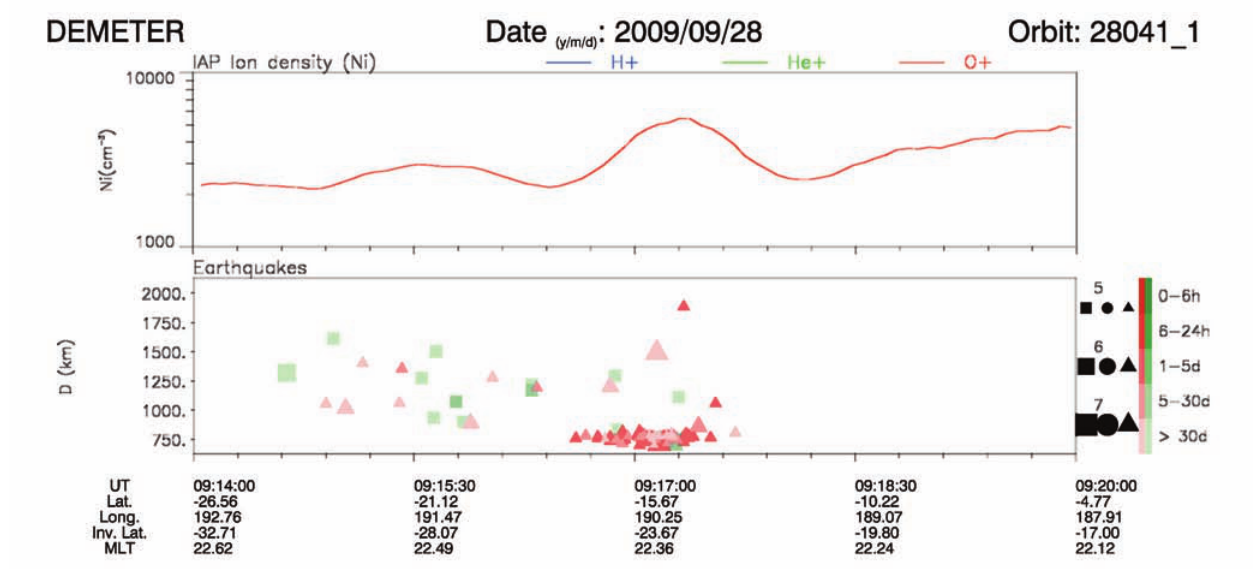
Figure 2. Data recorded on September 28, 2010, between 09.14.00 UT and 09.20.00 UT, 1 day before a powerful earthquake in the Samoa Islands. See Figure 1 for details.